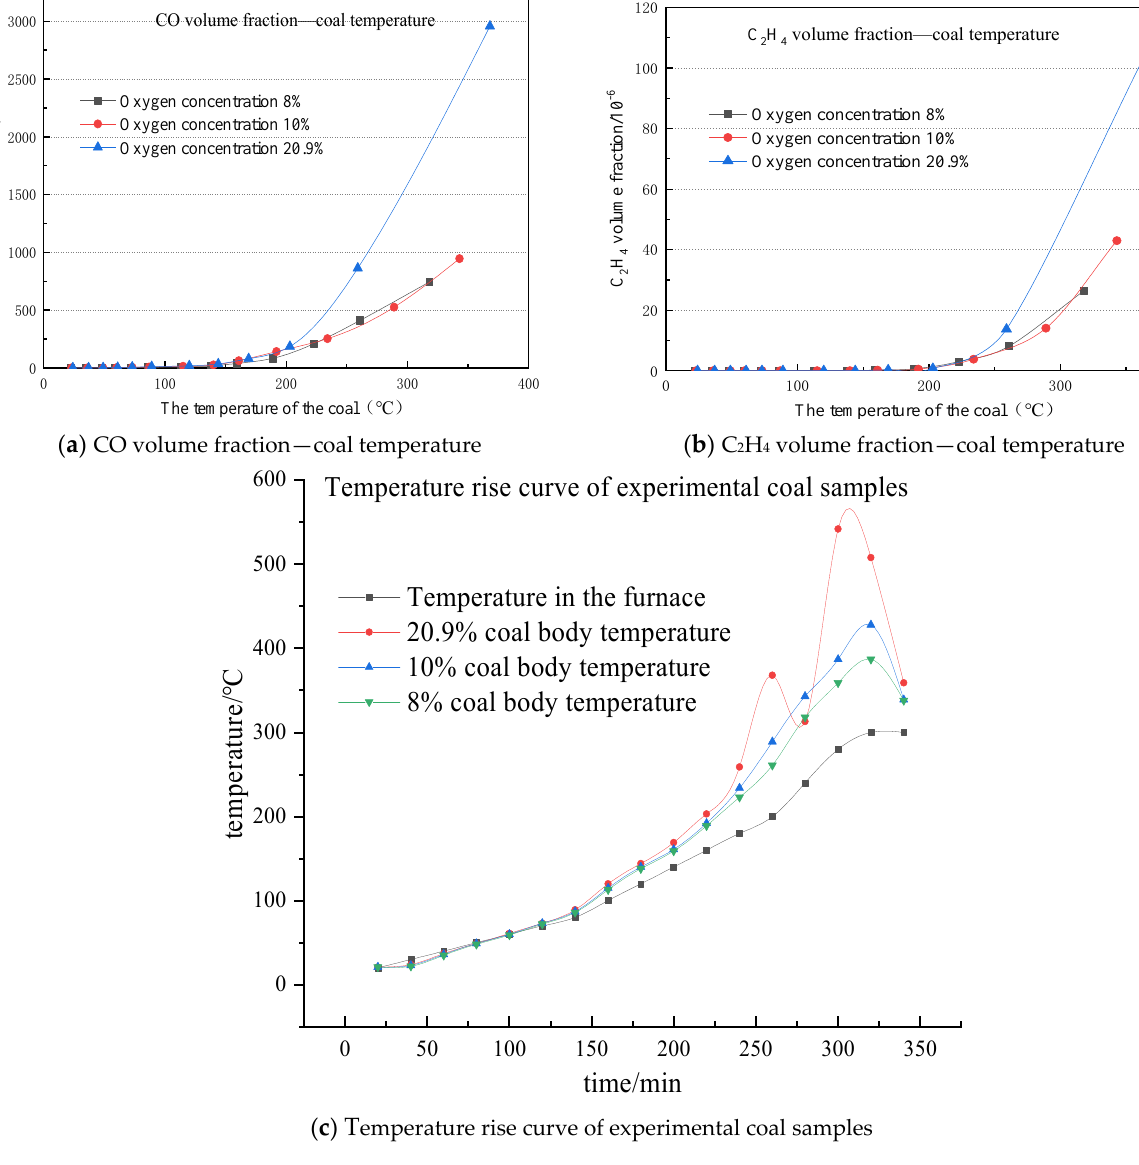
2 H 4 concentration changing with